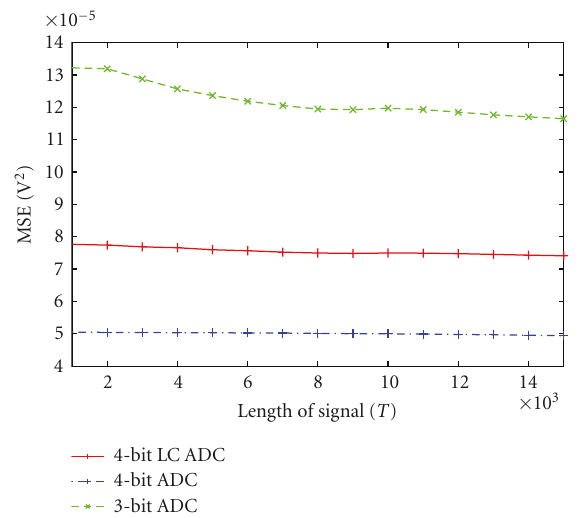
Figure 7: The performance of LC sampling compared to that of uniform sampling. The red straight line indicates MSE of using a 4-bit LC ADC; the green dashed line represents the MSE of using a 3-bit (Nyquist-rate) ADC; the blue dot-dash line is that of using a 4-bit (Nyquist-rate) ADC.